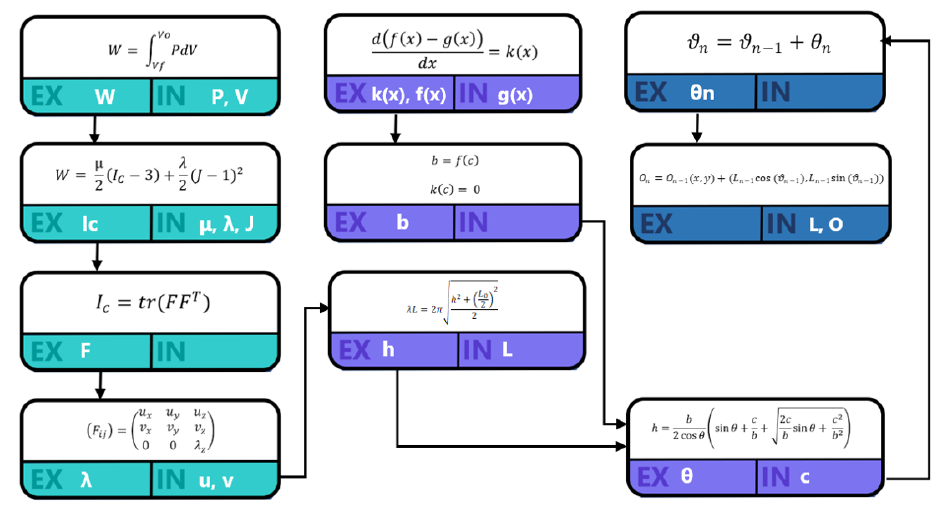
Figure 11. Mathematical Model’s Equation Flow.